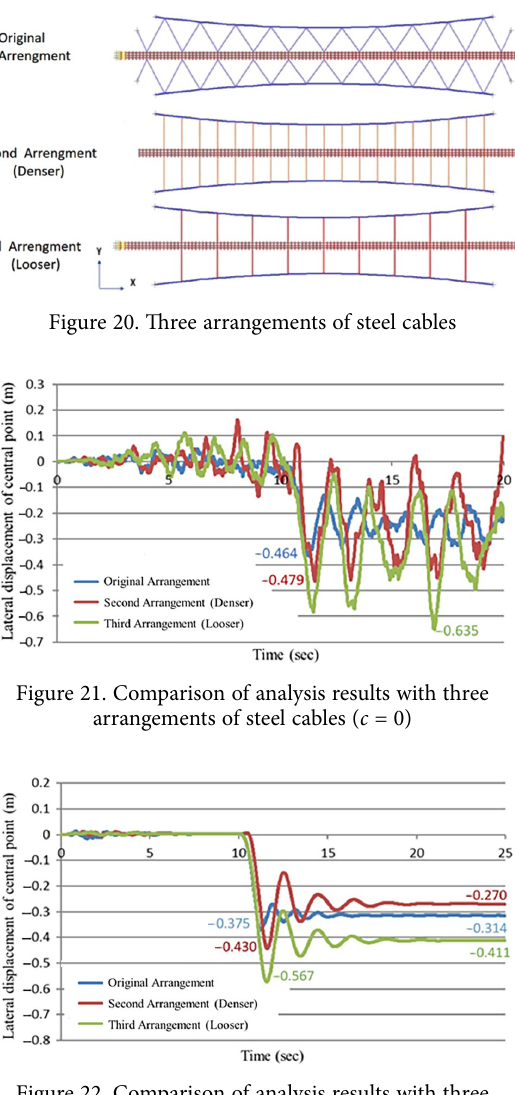
Figure 22. Comparison of analysis results with three arrangements of steel cables ( c =